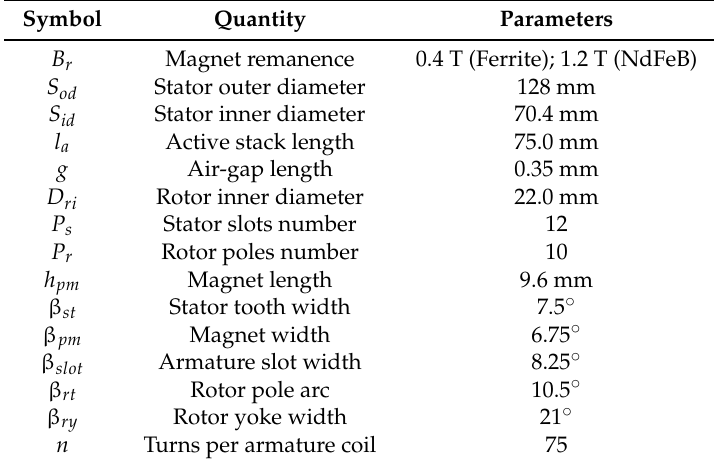
Table 1. Design specifications of the 12-stator-slots/10-rotor-poles HEFS